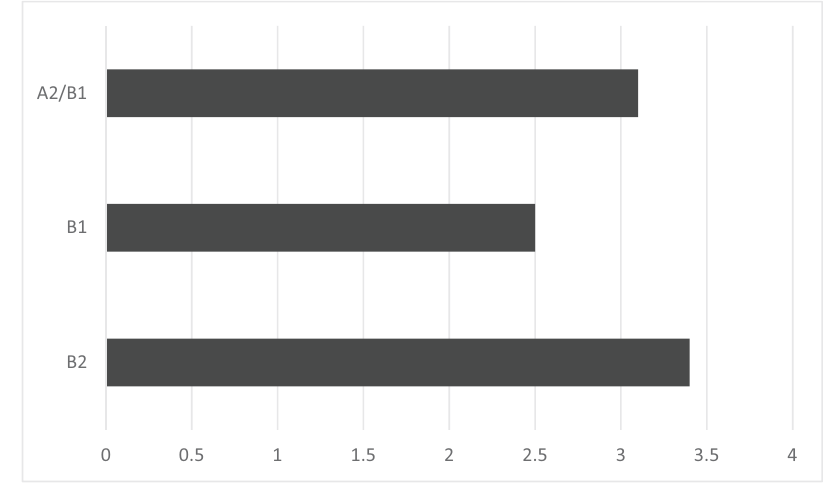
Figure 2: Language level at the time of the survey compared to the time of residence in